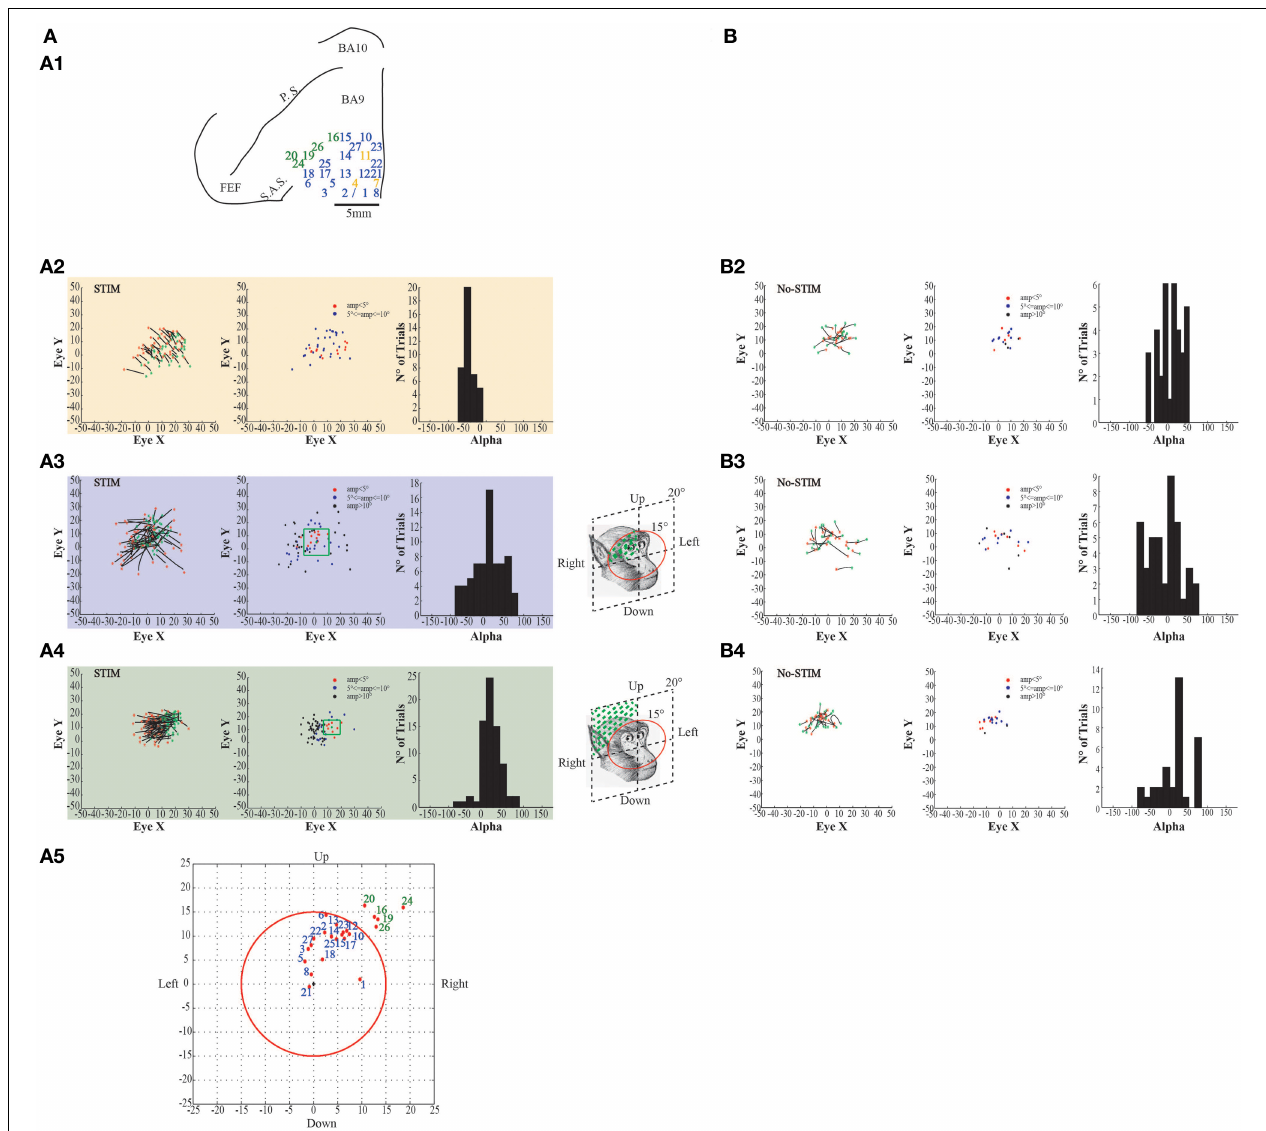
FIGURE 7 | Example of evoked eye movements. (A) The figures show data from Monkey S. For further information on the figures the reader should refer to the legend of Figure 6